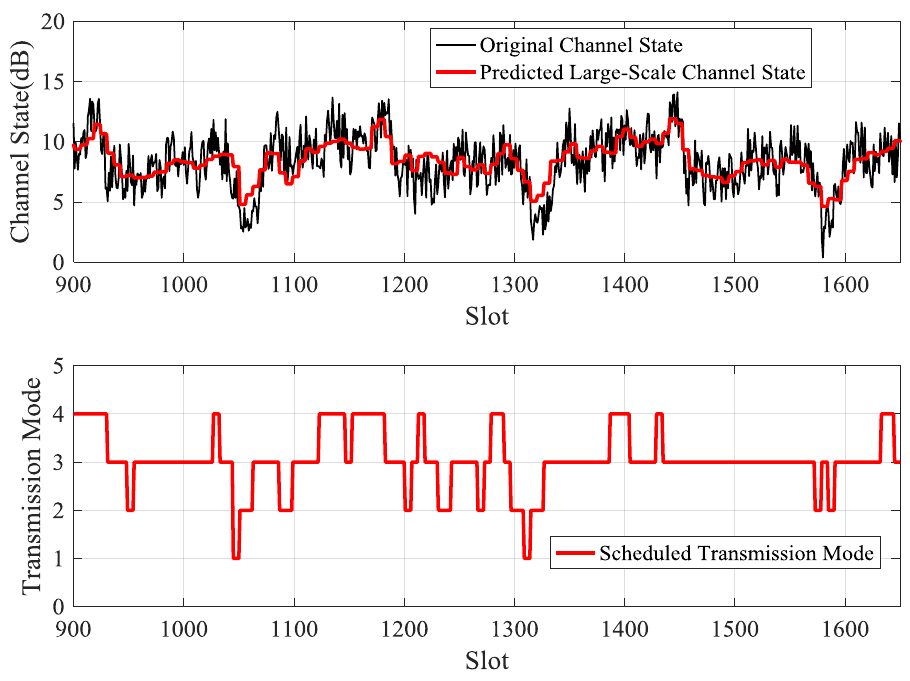
Figure 22. Scheduled transmission mode according to predicted large-scale channel state for Data 2.